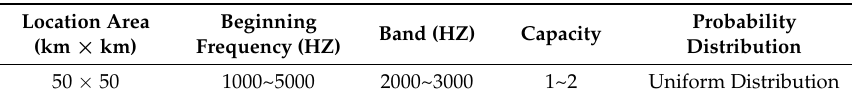
Table 3. Parameter settings for the task scenario.